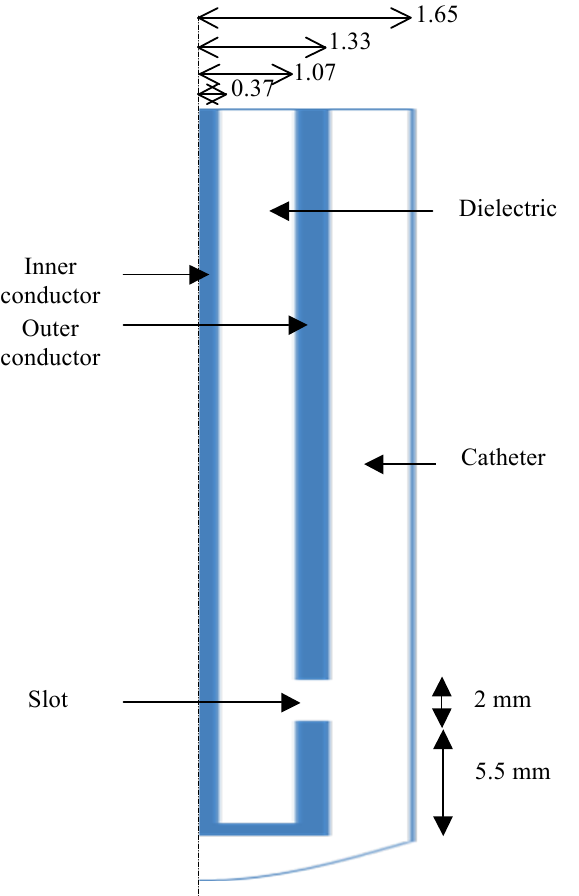
Figure 1: 2D Axisymetric view of the single slot MCA The dimensions of the MCA are chosen so that it allows interstitial treatment of the cancer in a minimally invasive way.